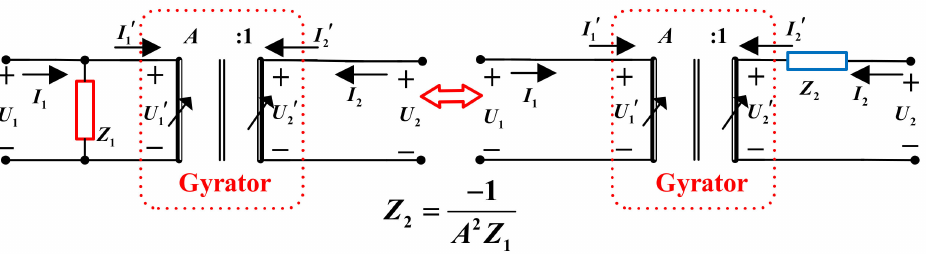
Figure 9. Impedance inversion of a